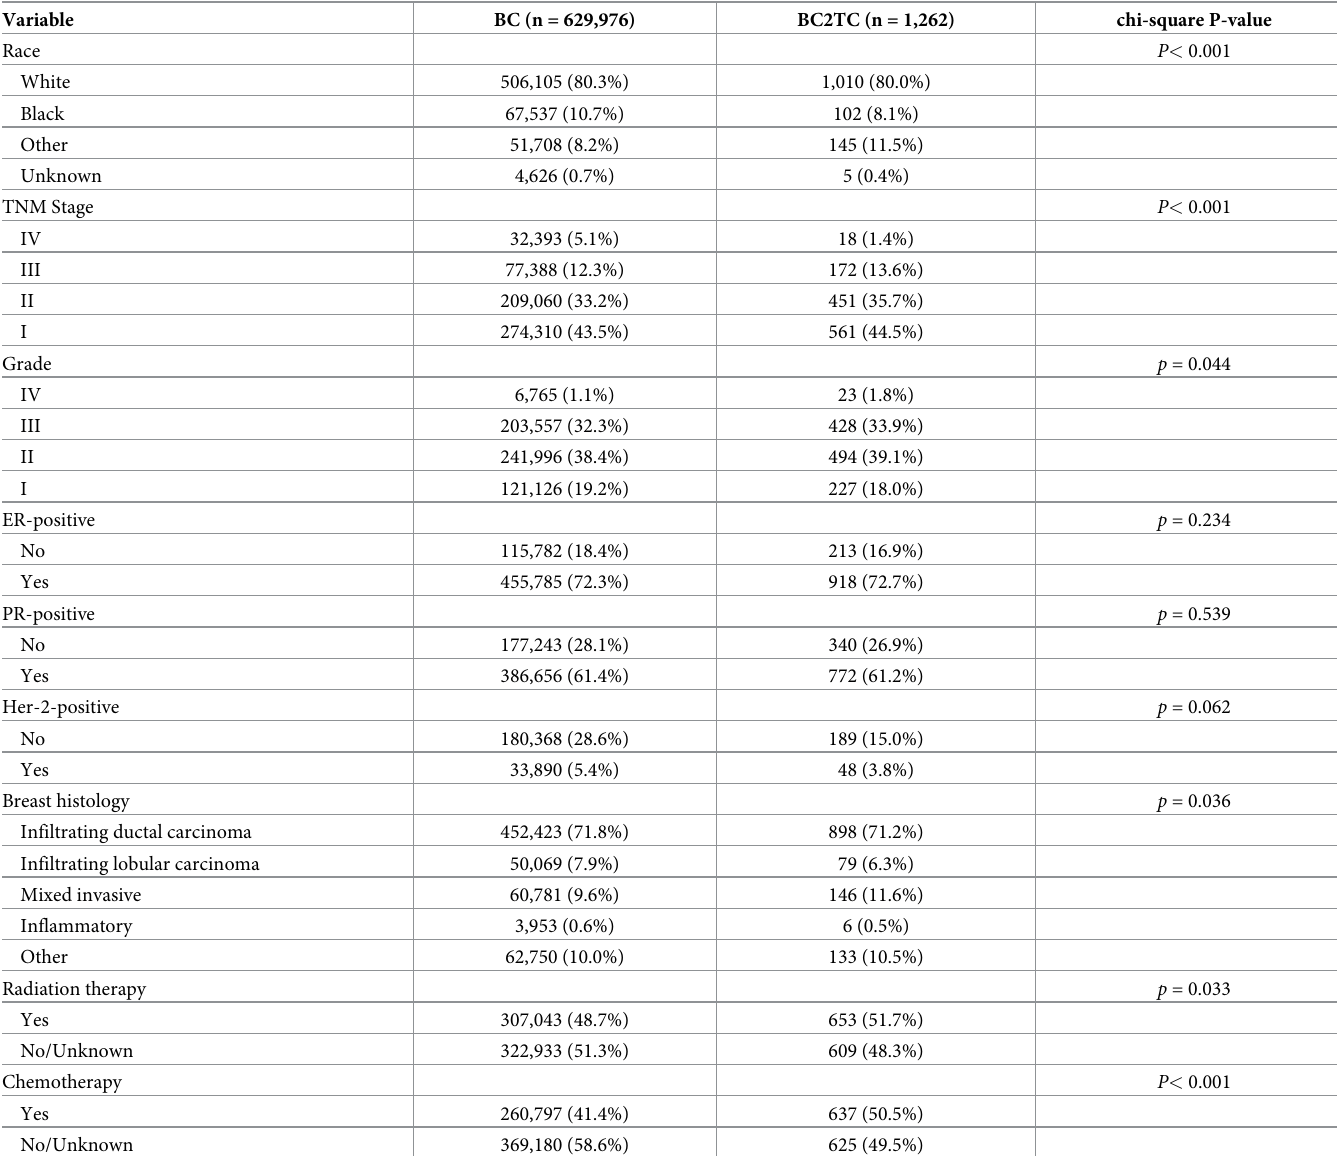
Table 2. Clinical characteristics of patients with only BC (BC group) and those with BC followed by TC (BC2TC